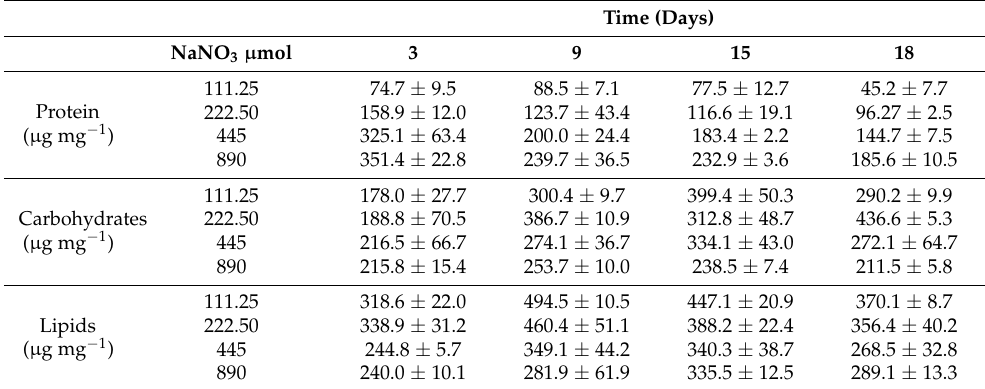
Values represent equations 1 and 2 parameters and therefore describe the whole growth curves. Table 3. Total protein, carbohydrate and lipid contents (mean value and standard deviation) of Thalassiosira weissflogii dry biomass at different days, cultured at four different nitrogen concentrations of NaNO 3